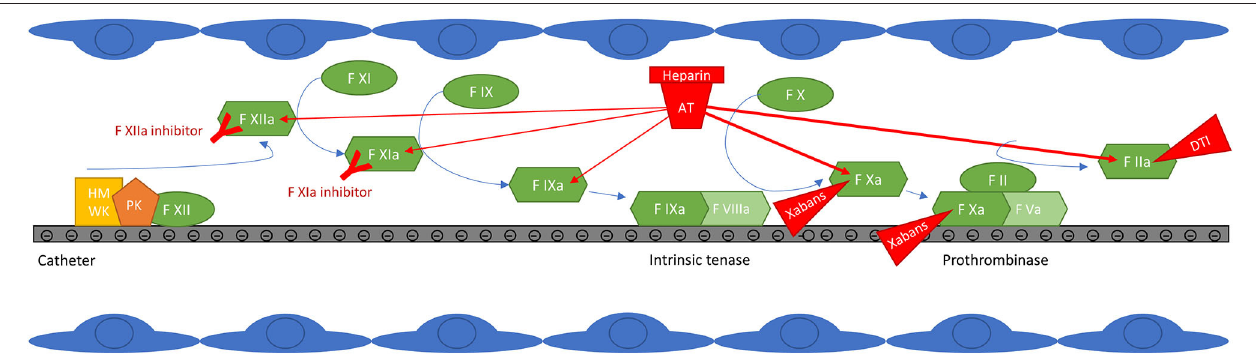
FIGURE 1 | Contact pathway activation at the surface of catheters and targets of anticoagulant drugs. Factor XIIa auto-activates on contact with negatively charged surfaces. High molecular weight kininogen (HMWK) is also adsorbed and serves as a cofactor for FXIIa auto-activation. FXIIa then activates FXI to initiate thrombin generation, but also prekallikrein (PK) to kallikrein, resulting in further FXIIa generation. FXIa activates FIX, which forms the intrinsic tenase with FVIIIa. Intrinsic tenase and prothrombinase complexes form on negatively charged surfaces, classically on the surface of activated platelets, but possibly also on the surface of catheters. The thrombin generated then amplifies the reaction by promoting the activation of factors XI, VIII and V, but it is also a potent platelet activator. In addition to the generation of thrombin initiated by FXIIa, other thrombotic mechanisms take place on the surface of catheters (not shown in the figure): the adsorption of proteins such as fibrinogen, which promotes the adhesion and activation of platelets and leukocytes, potentially increasing thrombin generation and thrombogenesis ( 47–51). FXIIa, kallikrein and thrombin also activate the complement system which promotes platelet activation and thrombin generation (53–57). The effect of anticoagulant drugs is also depicted: unfractionated heparin (UFH) potentiates the inhibitory effect of antithrombin (AT) mainly on free activated factors X and II, but also to a lesser extent on free activated factors IX, XI and XII (86); clot-bound FXa and FIIa, and FXa within the prothrombinase complex, are less accessible to inhibition by AT (87–89). Direct oral anticoagulants (direct F Xa inhibitors (xabans) and the direct thrombin inhibitor (DTI) dabigatran) directly inhibit activated factor II or X, free, within the prothrombinase complex and clot-bound (89–92). Contact pathway inhibitors specifically target factor XI or XII; truncated antibodies against FXIa or FXIIa are shown in the figure, but this category also includes small inhibiting molecules, antisense oligonucleotides and small interfering RNAs